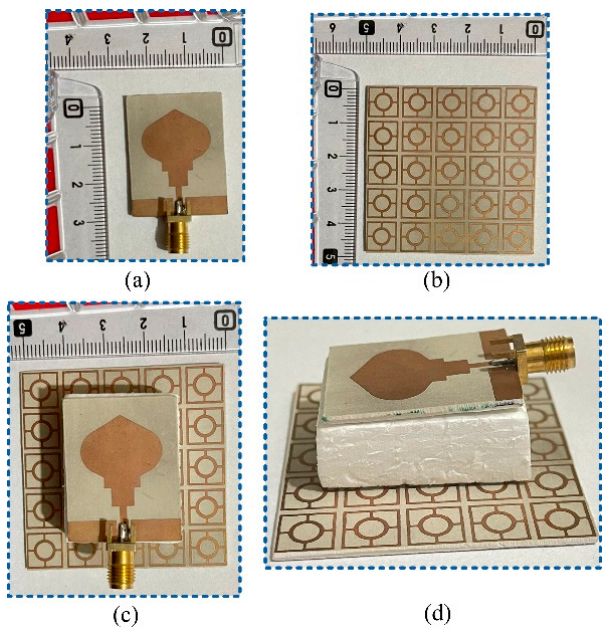
Figure 8. Fabricated prototype of ( a ) UWB antenna; ( b ) FSS design; ( c ) antenna placed at FSS layer; ( d ) side view of antenna placed over FSS layer.